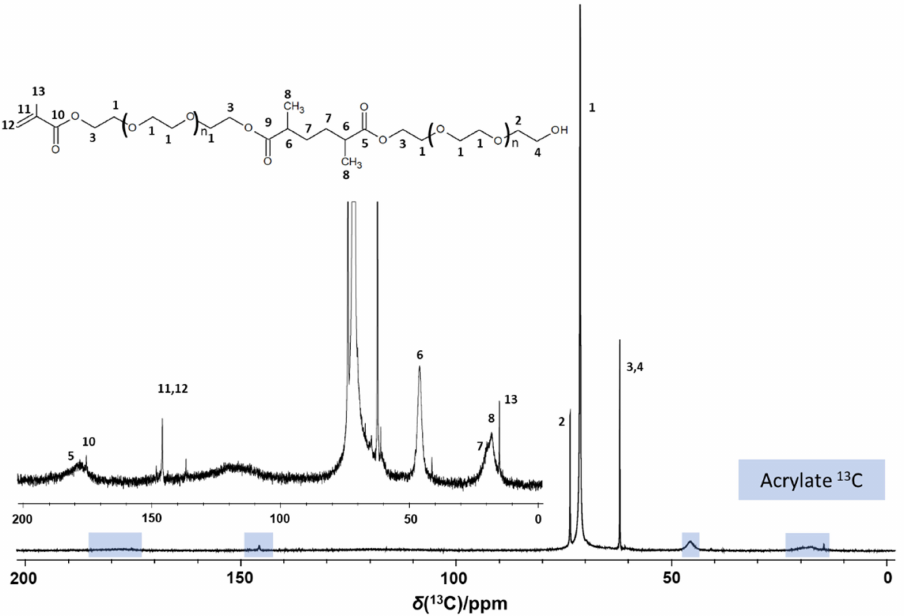
Figure 1. 1 H decoupled 13 C direct excitation solid-state NMR spectrum of the PEGMA support. Zoomed in section is given in the